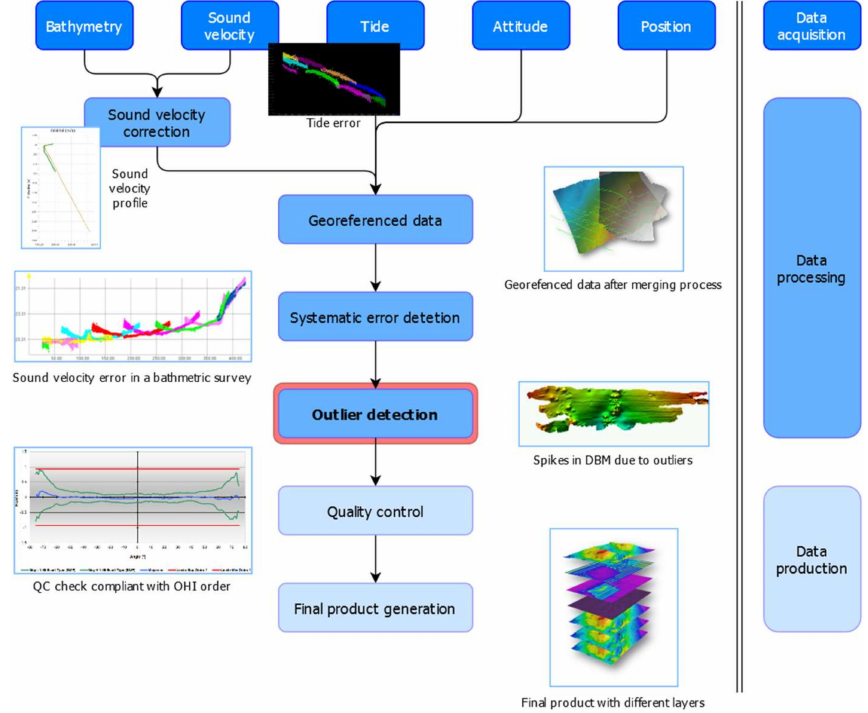
Figure 3. Bathymetric